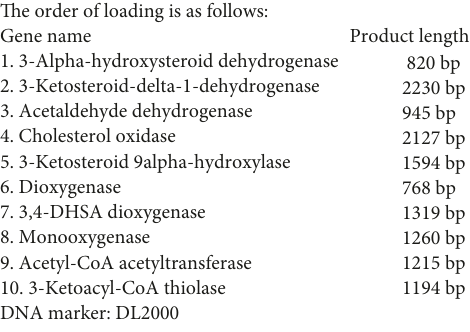
Figure 6: PCR agarose gel electrophoresis.